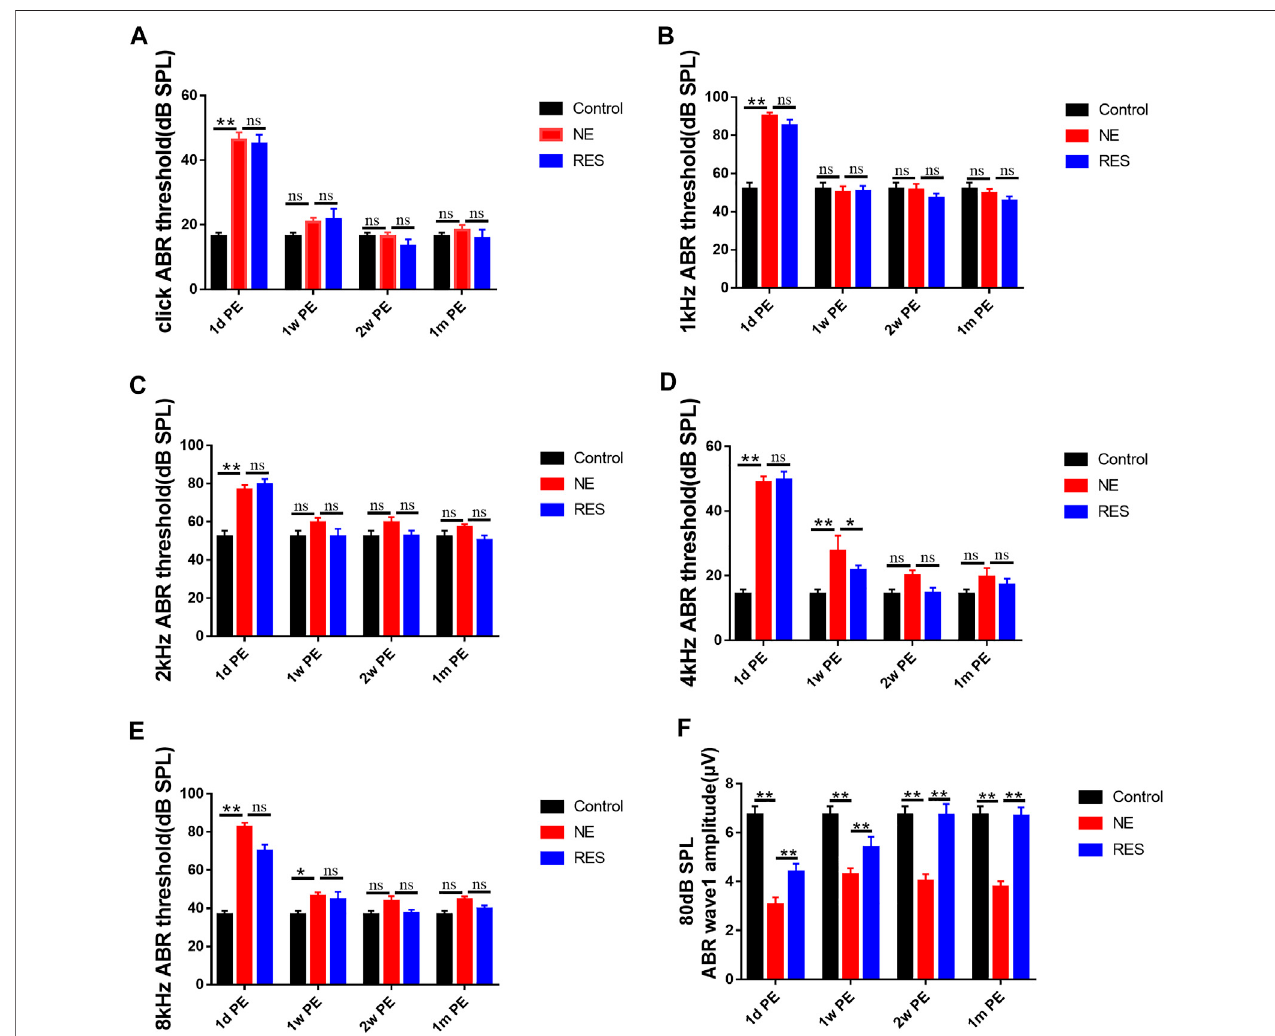
FIGURE 1 | ABR after noise exposure, the values are presented as the means ± SEM. (A) – (E) The alterations of ABR threshold of guinea pigs in each group after 105dB SPL military helicopter noise exposure. (F) The alterations of 80 dB SPL ABR wave I amplitude of guinea pigs in each group after 105dB SPL military helicopter noise exposure (µV). Note: n = 12 ears from 6 animals in each group. * p < 0.05, ** p < 0.01.